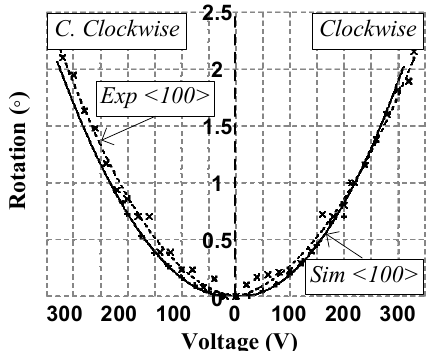
Figure 7. Measured and simulated platform angular displacement for left and right actuation of the first design where the “+” data points represent simulated data, the solid line is a fit to the simulated data, the “ × ” data points represent experimental measurements, and the dotted line is a fit to the experimental measurements.